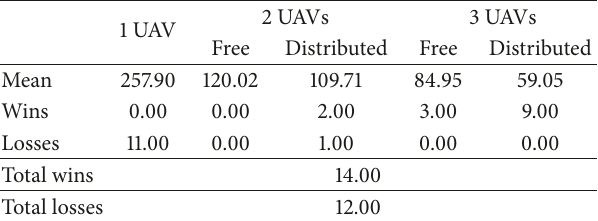
Table 9: Time results with fuzzy logic path planning.